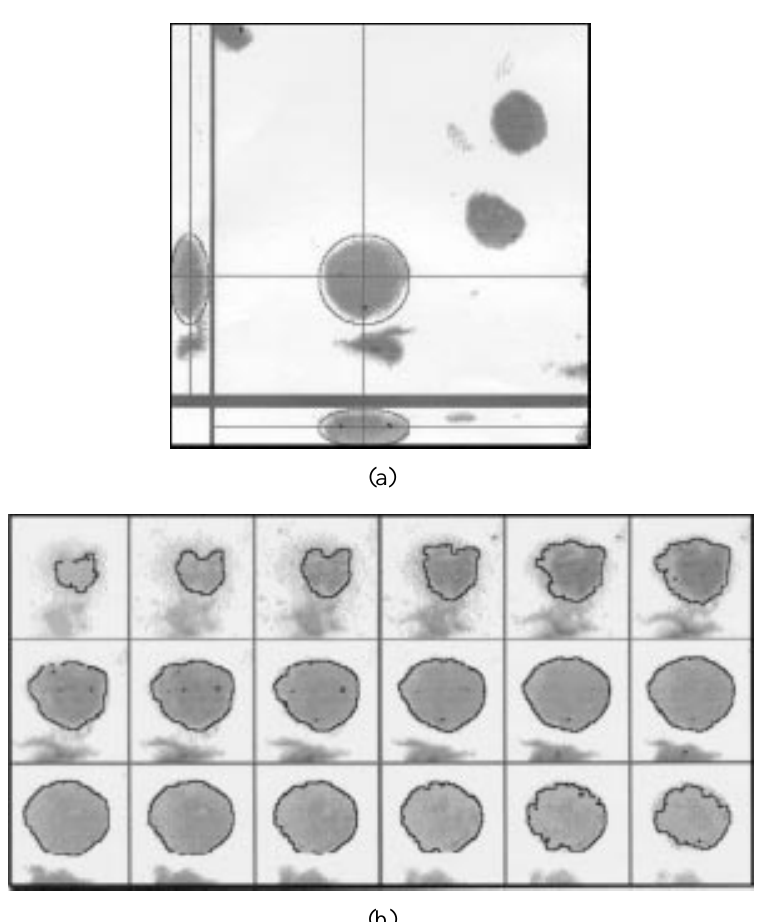
Fig. 7. Results of segmentation on a different data set. (a) Initialization shown over one XY , Y Z and XZ planes of the image stack. (b) Sequence of images in the stack showing the result of optimization of the deformable